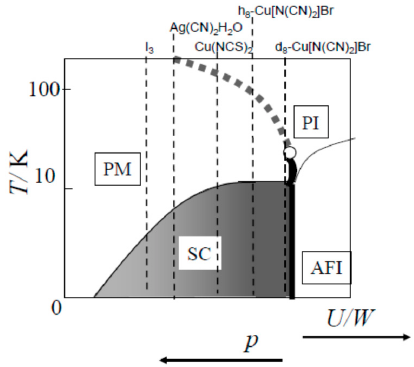
Figure 1. Electronic phase diagram of dimer-Mott compounds with a D 2 X composition. Diagram is constructed based on the chemical and external pressure dependences of the physical properties of κ - (BEDT-TTF) 2 X compounds by Kanoda in Refs. [14,15]. Position of several compounds with different counter-anions are shown by dashed lines. Horizontal axis is the U/W ratio, which is tunable by an external pressure.